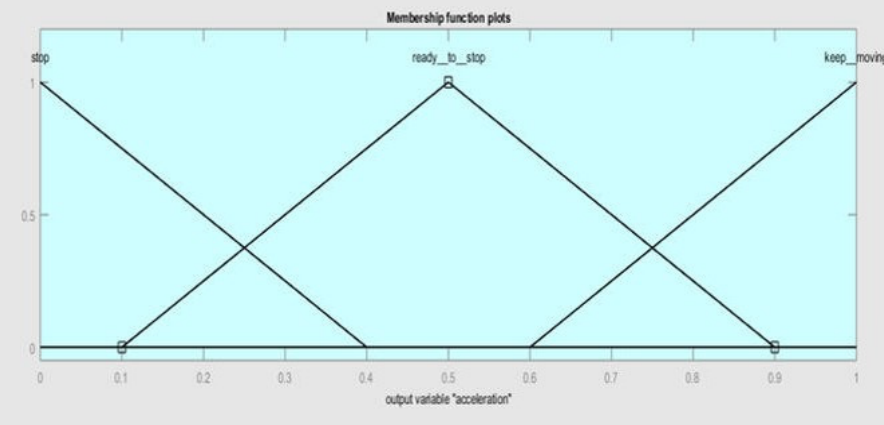
Figure 8. Membership functions of output 1 (acceleration).